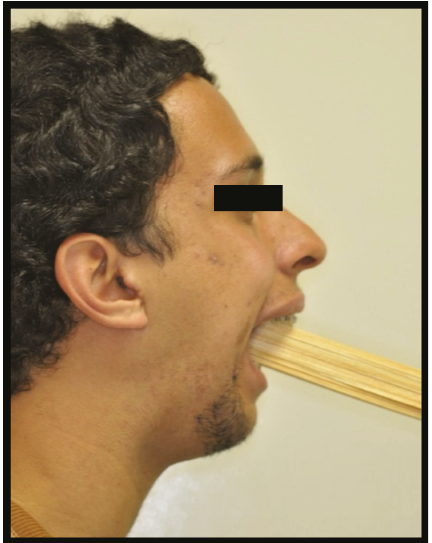
Figure 14: Physiotherapy with 15 wooden spatulas after 15 days of postsurgery.